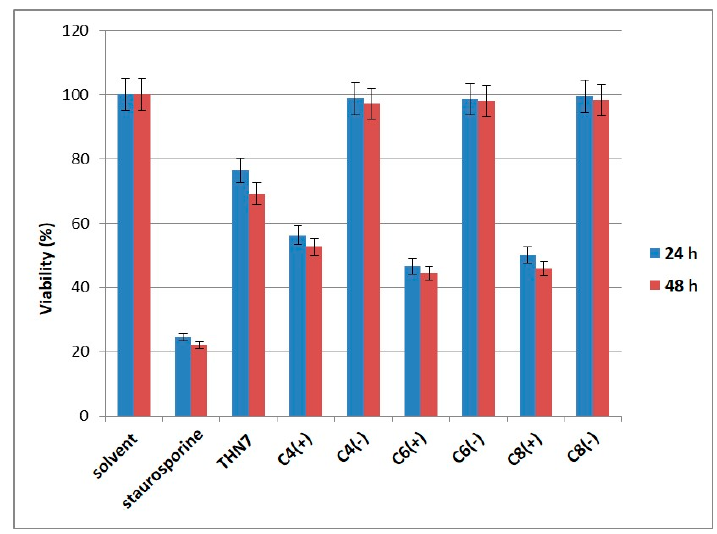
Figure 5. Cytotoxic activity of THN7 ‐ loaded α‐ cyclodextrin nanoparticles on A ‐ 427 lung cancer cells. C4: C 4 H 9 ; C6: C 6 H 13 ; C8: C 8 H 17 . (+) loaded cyclodextrins; ( − ) empty cyclodextrins. Viability of A427